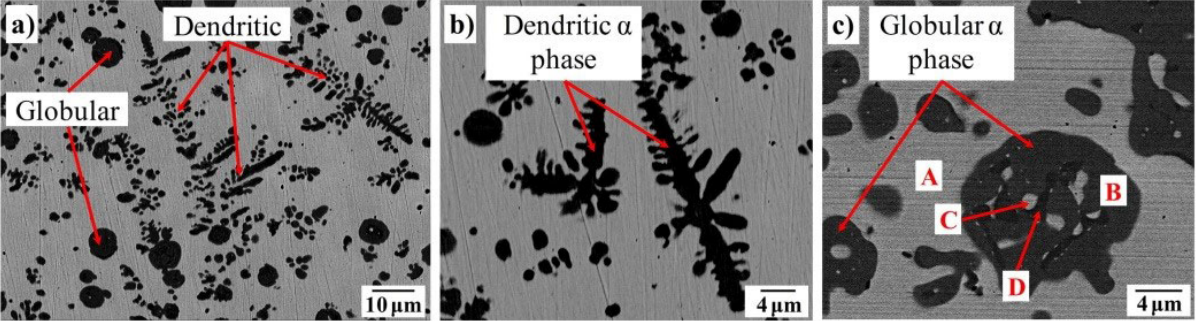
Figure 10. SEM images for the first copper layer: ( a ) low magnification image, ( b ) dendritic morphology, ( c ) globular morphology [157].